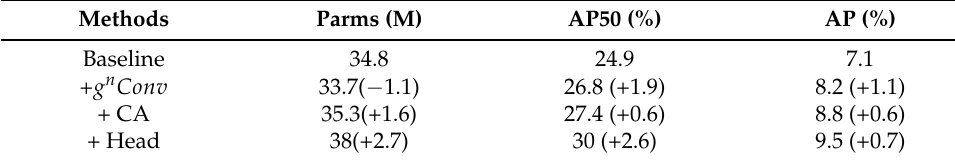
Table 1. Ablation experiments on the TinyPerson